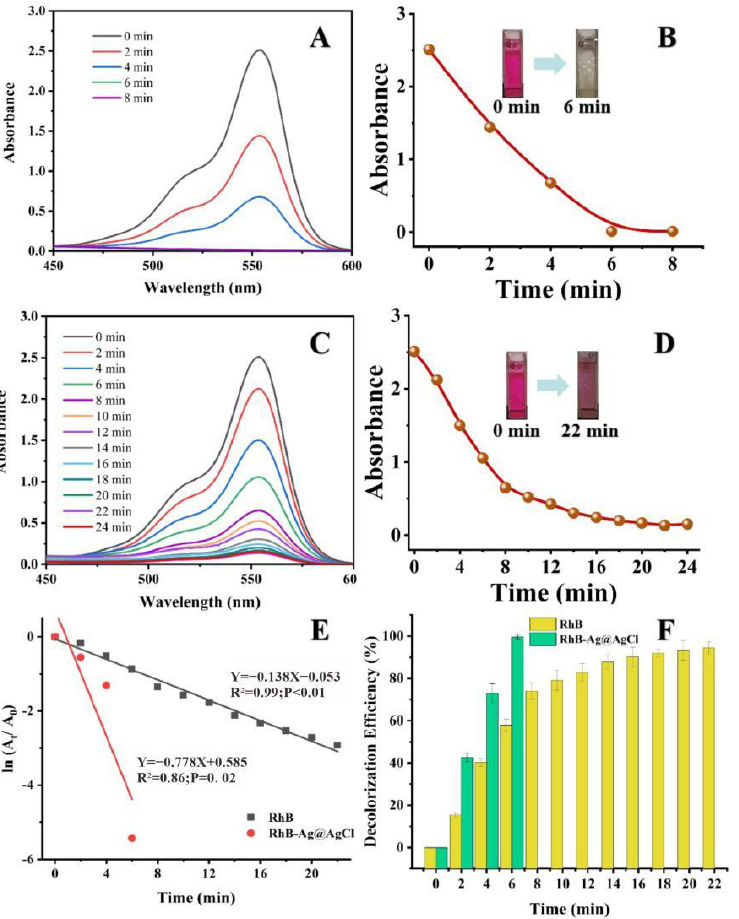
Figure 7. The reduction of RhB in aqueous solution recorded every 2 min: the Uv-vis spectral of RhB reaction with Ag@AgCl nanoparticles ( A ) and without ( C ). Digital images of RhB reaction with Ag@AgCl nanoparticles ( B ) and without ( D ). ln(A t /A 0 ) versus reaction time for RhB reduction ( E ). Decolourization efficiency versus reaction time for RhB reduction ( F ).